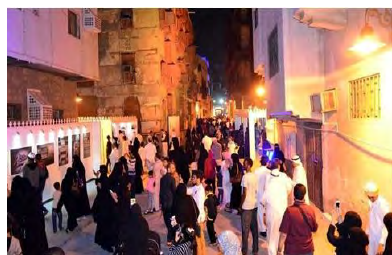
Figure 12. Show how people act with the displayed elements and what slower the movement among the paths